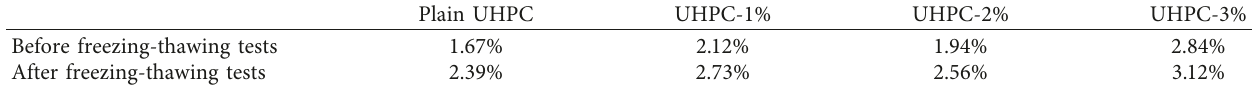
Table 3: Total volume fraction of defects in UHPC specimens before and after freezing-thawing